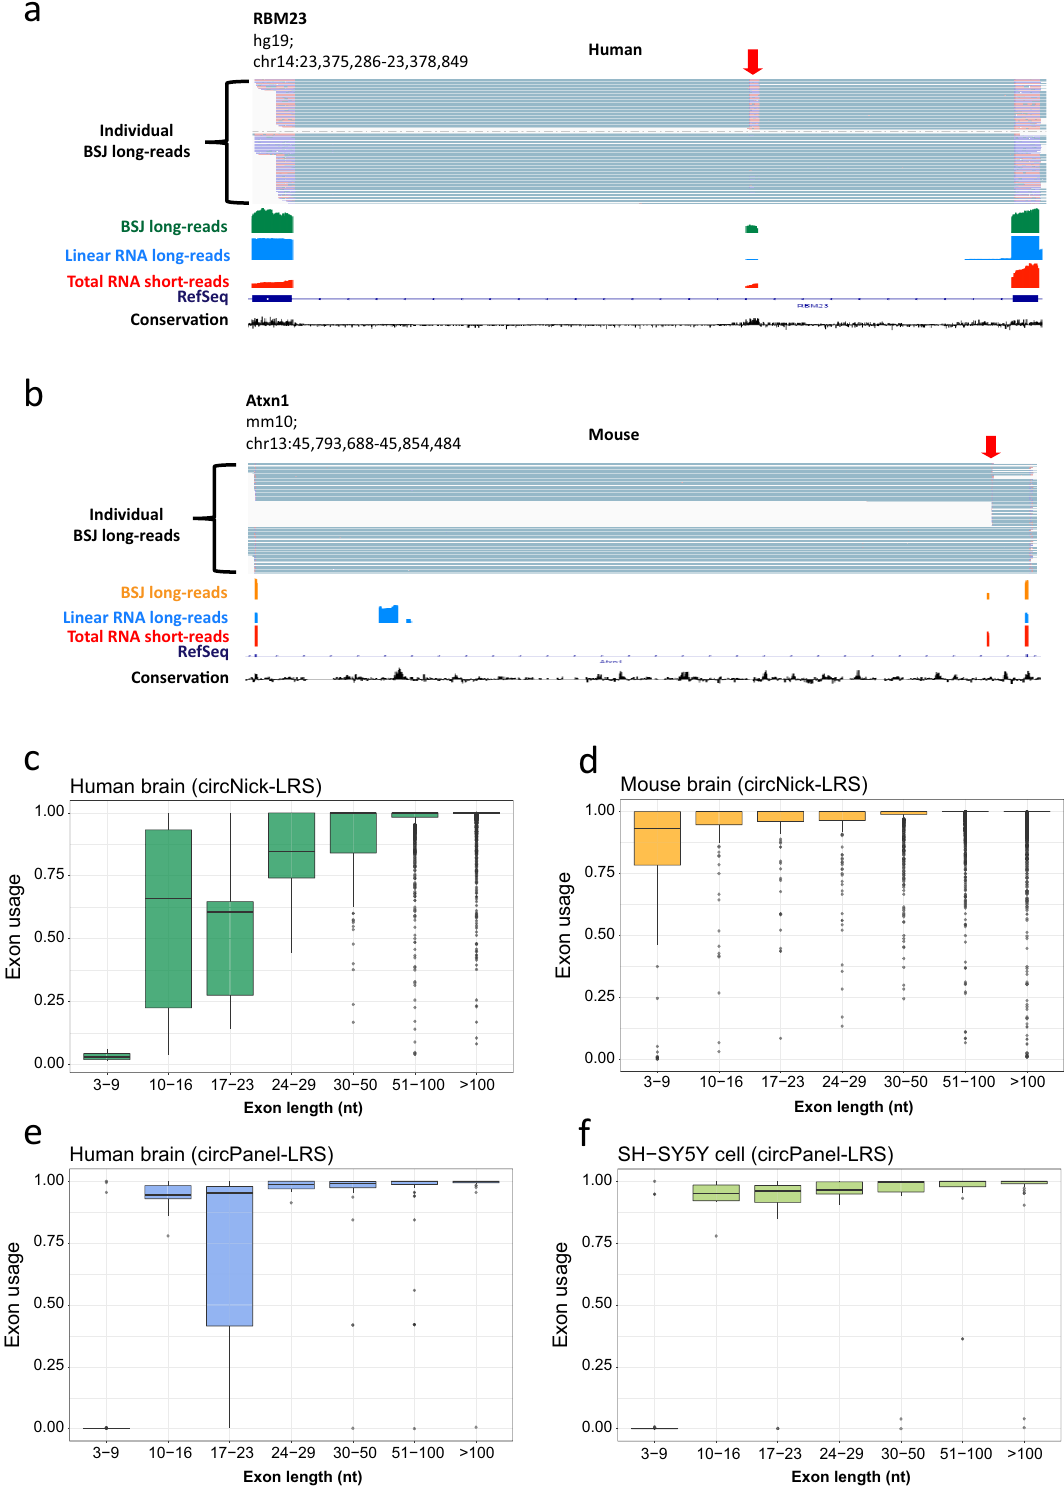
Fig. 4 Examples of circRNA-speci fi c alternative splicing. a Alternative splicing of circRBM23 (red arrow). The alternative exon is primarily included in circRNA. b Example of a circRNA-speci fi c exon in circAtxn1 (red arrow). See legend to Fig. 2 for the explanation of tracks. c – f The level of exon usage for various exon lengths are shown, ranging from no exon usage, 0 on y -scale, to constitutive exons, 1 on y -scale. Box plot hinges range from the 25th to the 75th percentile, correspond to the fi rst and third quartiles. Horizontal lines indicate median. The upper whisker extends from the hinge to the largest value, but no further than the 75th percentile + 1.5×IQR, where IQR is the inter-quartile range, or distance between the fi rst and third quartiles. The lower whisker extends from the hinge to the smallest value, but no further than the 25th percentile − 1.5×IQR. Dots represent exon lengths outside this boundary. Shown for the samples c Human brain (circNick-LRS), d Mouse brain (circNick-LRS), e Human brain (circPanel-LRS), and f SH-SY5Y cells